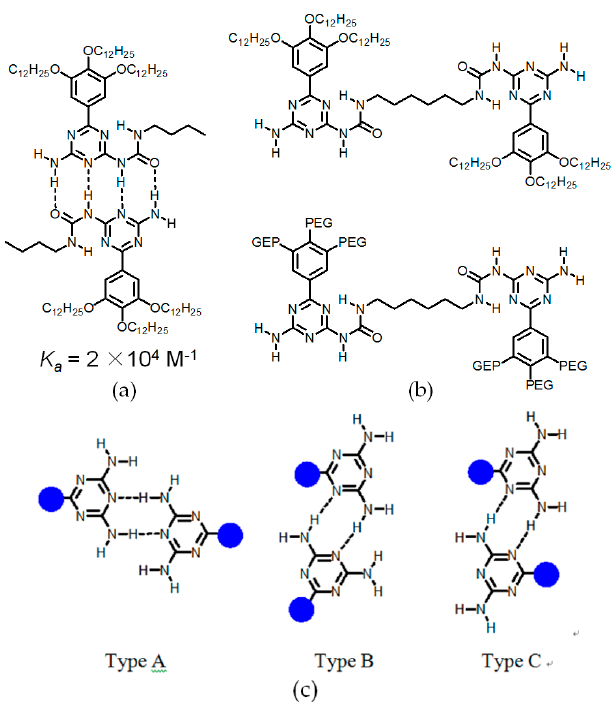
Figure 18. ( a ) Representative example of DAT based hydrogen bonding array; ( b ) supramolecular polymeric monomers containing DAT moieties; ( c ) feasible hydrogen-bonding assembled patterns between DAT–DAT